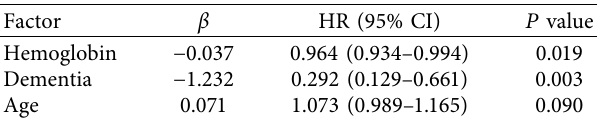
Table 4: Cox’s proportional hazards regression model (enter method): Related factors of death related to LRTIs within 1 year of discharge.